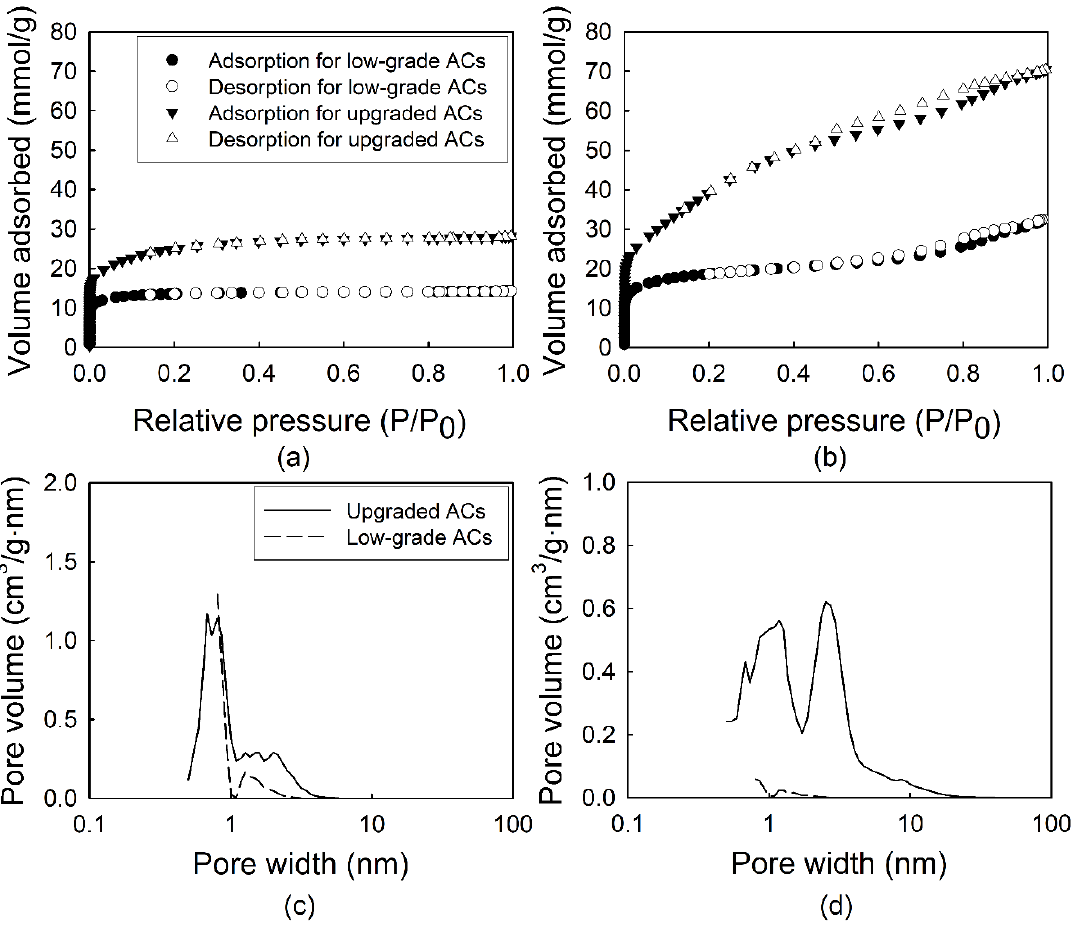
Figure 1. Nitrogen ad-/de-sorption isotherms and pore size distribution for coconut ( a , c ) and wood ( b , d ) based ACs (activated carbons). These ACs were classified into low and upgraded without/with KOH treatment.